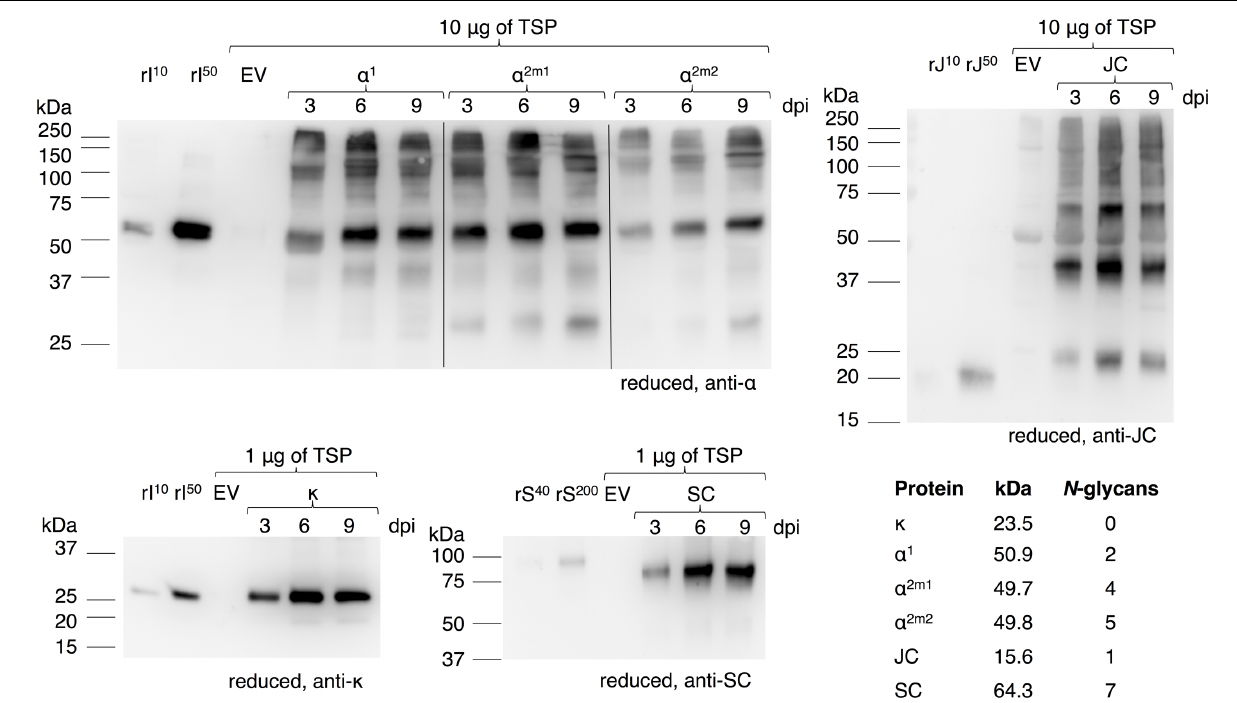
Frontiers in Plant Science |